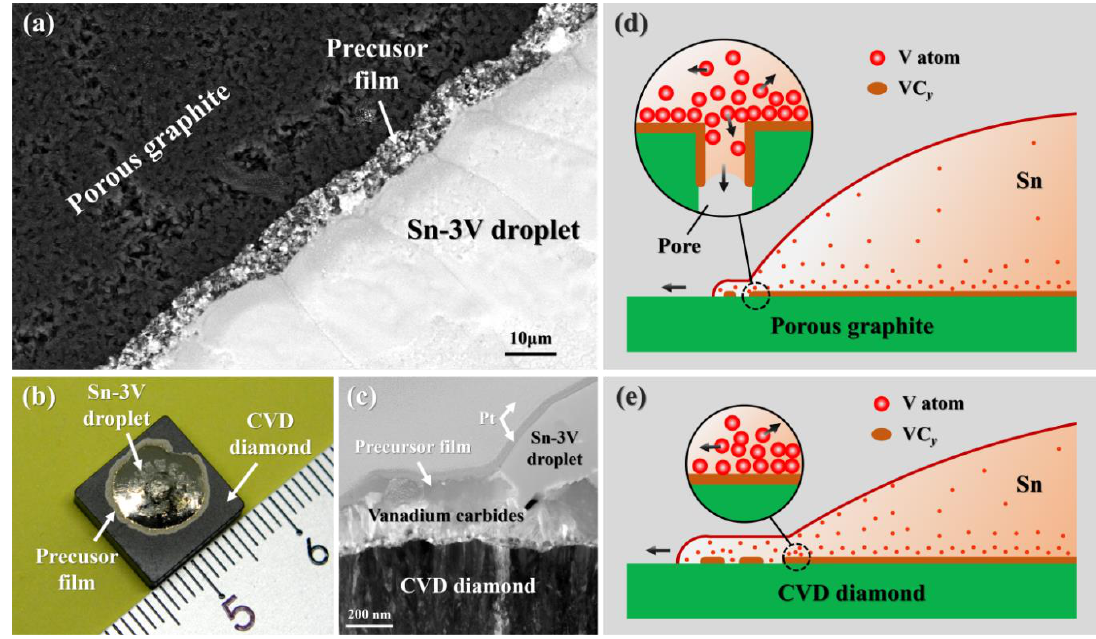
Figure 11. ( a ) top-view SEM micrograph near to the wetting edge of Sn-3V alloy on porous graphite after wetting at 950 °C, ( b ) appearance of Sn-3V alloy/CVD diamond sample wetted at 950 °C, ( c ) bright field TEM image of cross-sectional microstructure at the three-phase contact line of Sn-3V/CVD diamond wetted at 950 °C. The schematic illustration of mass transfer at the triple lines of Sn-3V alloy on ( d ) porous graphite and ( e ) CVD diamond.